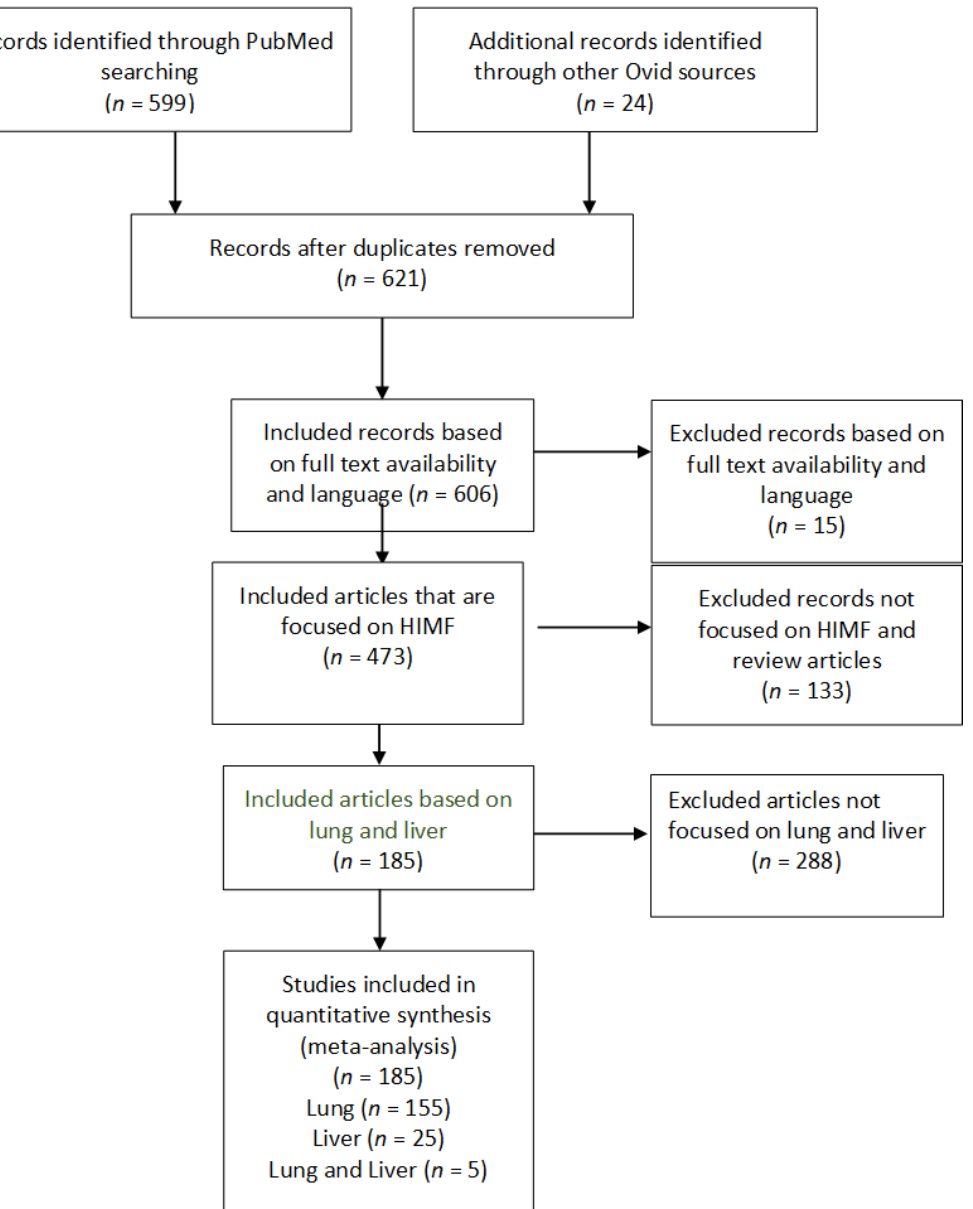
Figure 1. PRISMA study selection flow diagram. The PRISMA flow diagram demonstrates each phase of the search strategy in which articles were evaluated. During each phase, articles were excluded based on our defined criteria. The last phase of exclusion resulted in a final collection of articles, which were then divided by organ systems.